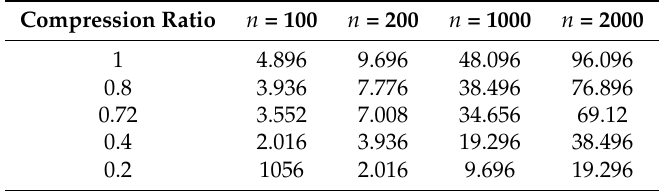
Table 2. Energy consumption (10 3 nJ) under different compression